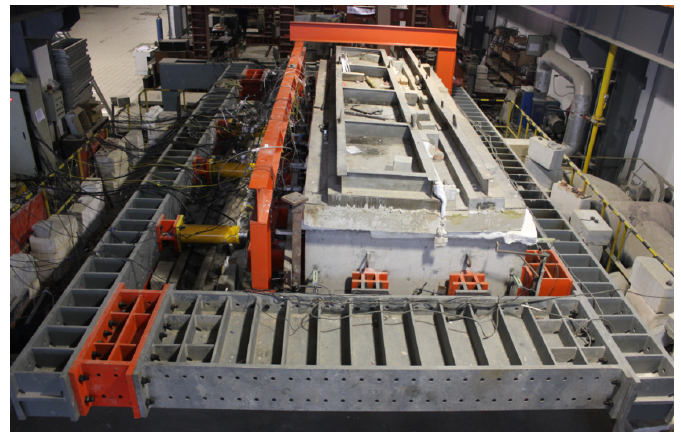
Figure 2. Setup of the large-scale fire test, taken from [40]. The specimen was placed sidelong on top of the furnace and closed with a fire-resistant cover.